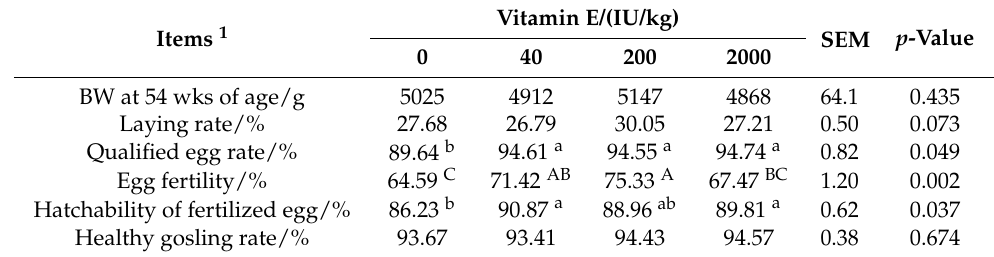
Table 2. Effects of dietary vitamin E supplementation on reproductive performance in breeding